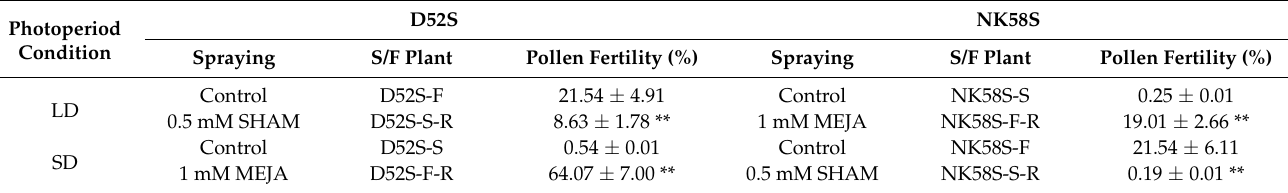
Table 2. Pollen fertility of D52S and NK58S by a MEJA/SHAM-spraying treatment. Photoperiod